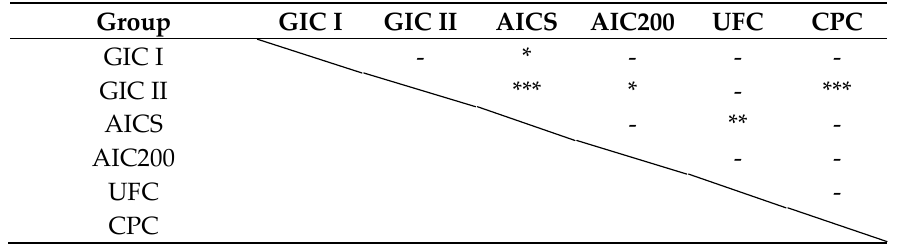
Table 6. Statistical significance of differences in the accumulated amounts of fluoride released after five days.